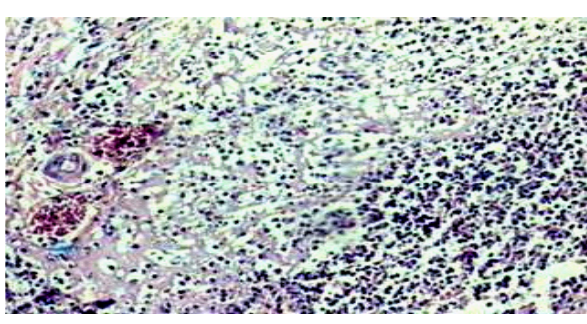
FIGURA 9 - Fotomicrografia com área de moderada proliferação fibroblástica e deposição de colágeno (subgrupo Jatropha 7º dia do pós-operatório, coloração masson, aumento 100x). Nota: Área com infiltrado inflamatório